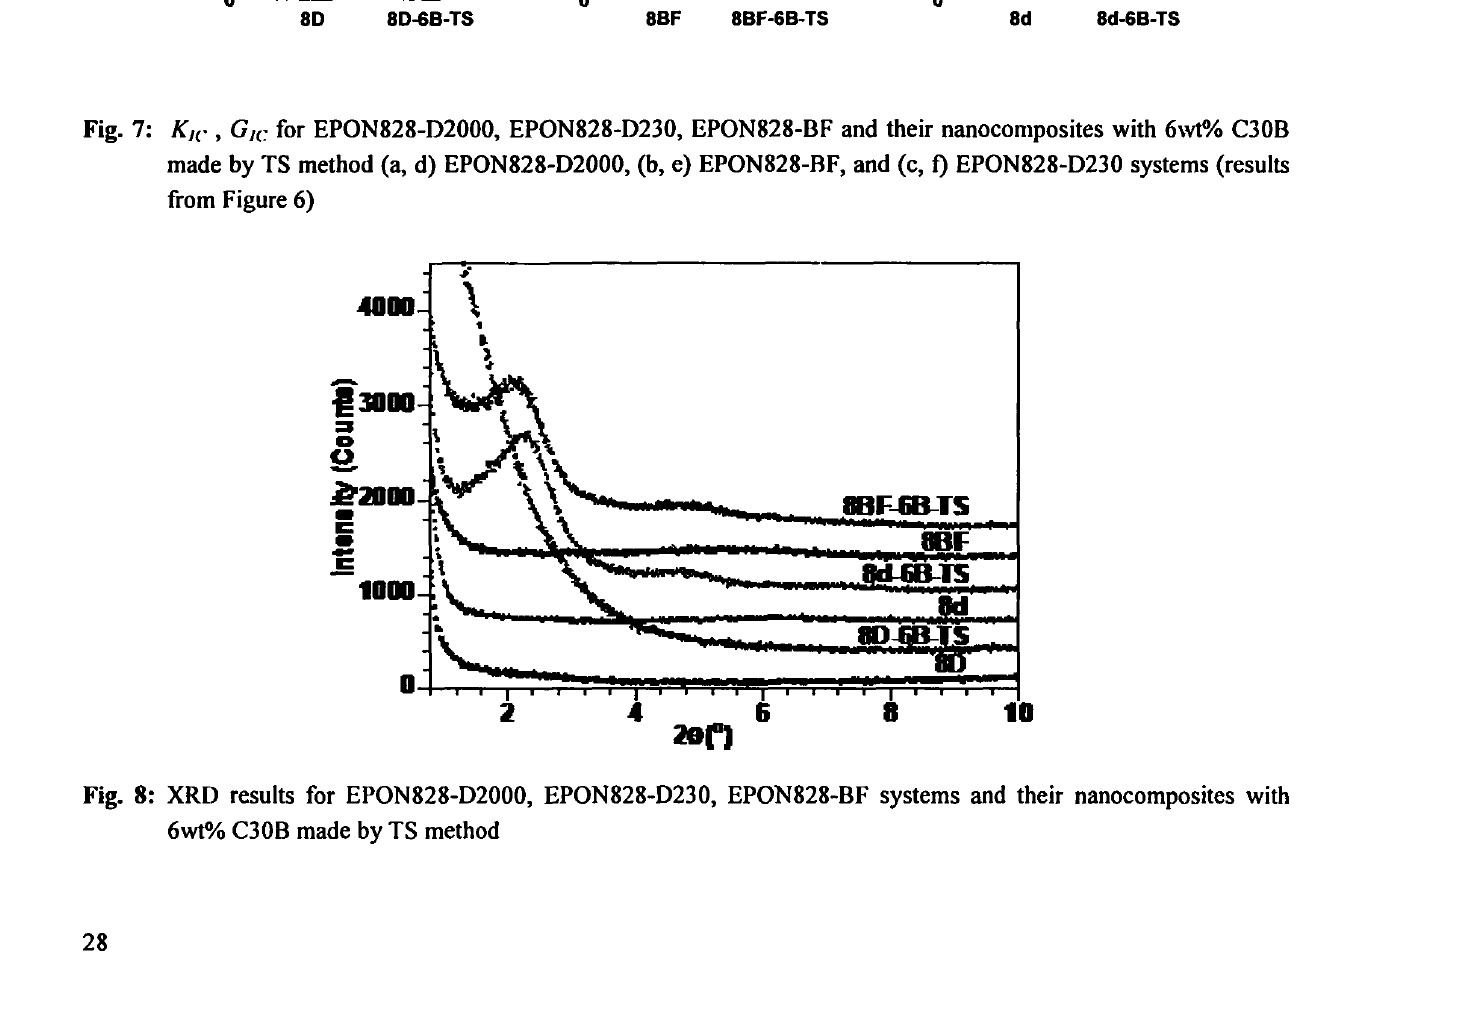
Fig. 8: XRD results for EPON828-D2000, EPON828-D230, EPON828-BF systems and their nanocomposites with 6wt% C30B made by TS method